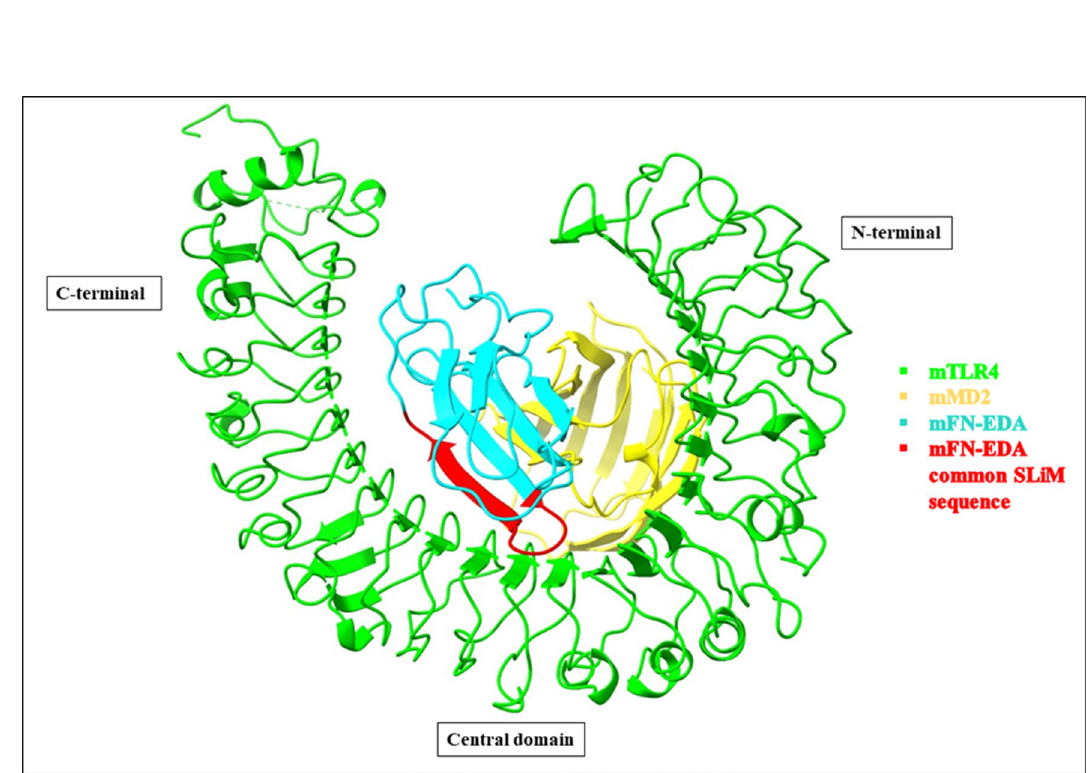
Figure 1. Representation of mouse TLR4-MD2-FN-EDA depicting the interacting peptide (SLiM sequence) of FN-EDA (“SPEDGIRELF”, highlighted in red) with the TLR4 in ChimeraX. All models of mouse FN-EDA SLiM sequences show interaction near the central and C-terminal region of TLR4.